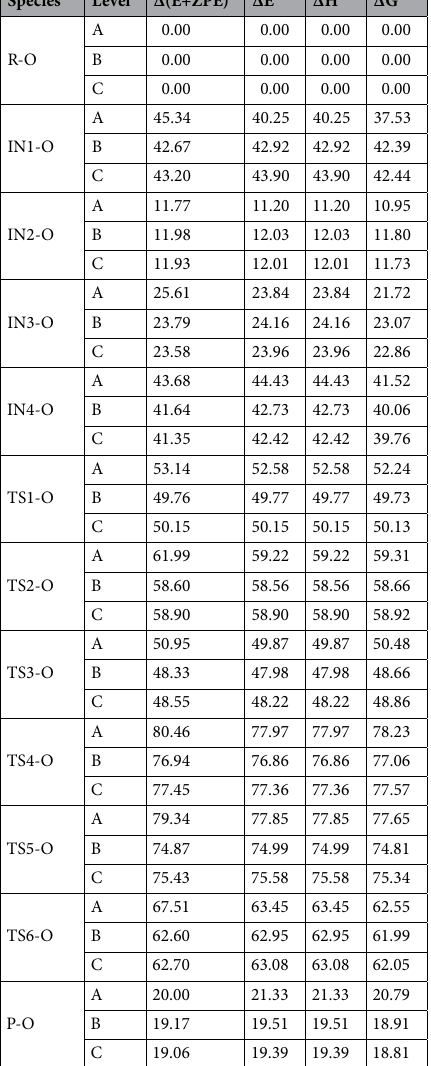
Table 4. Relative energies corrected by ZPE, thermal energies (ΔE°), enthalpy energies (ΔHº), and Gibbs free energies calculated for all stationary points of 3-hydroxyfuran-2(5H)-one unimolecular reaction at different levels. A, B, and C are CBS-QB3, M06-2X/Jun-cc-pVTZ, and M06-2X/6-311+g(2df,2p) levels,